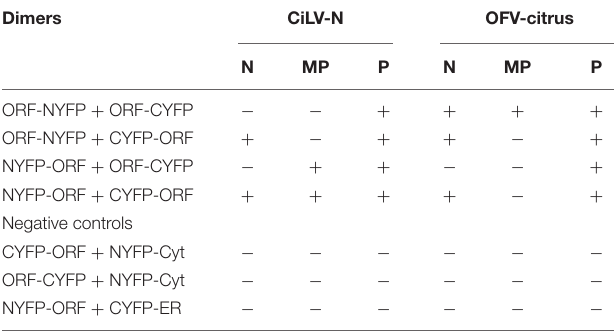
TABLE 2 | Protein pair combinations performed in the BiFC dimerization